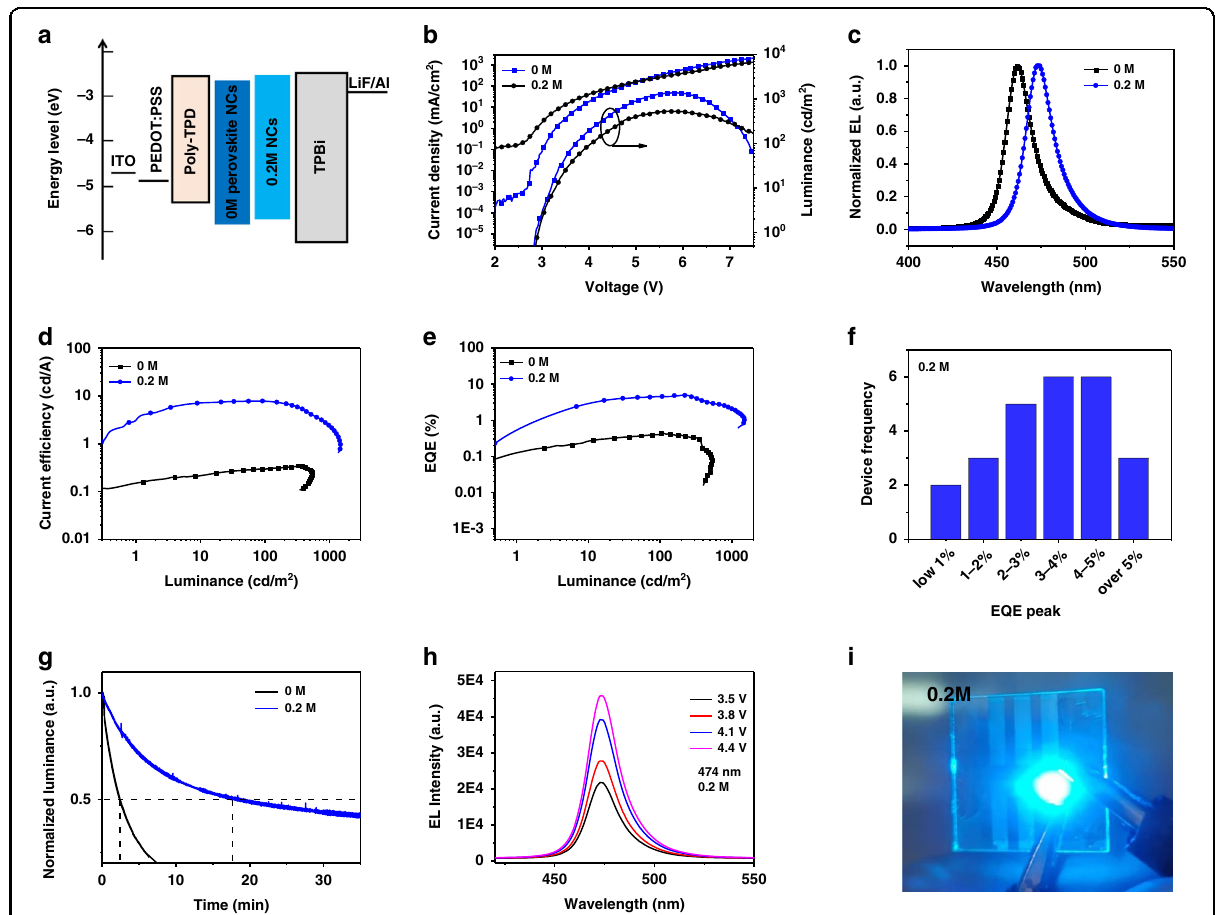
Fig. 6 Blue LED performances based on perovskite QDs. a Schematic band alignment of the LED devices with 0 and 0.2 M FA cation doped QDs. b Curves of the current density-voltage-luminance. c Normalized electroluminescence spectra of the LED devices with CsPb(Cl 0.5 Br 0.5 ) 3 (black curve) and 0.2 M doped CsPb(Cl 0.5 Br 0.5 ) 3 QDs (blue curve). d Curves of the brightness-current ef fi ciency. e Curves of the external quantum ef fi ciency- luminance. f The histogram of devices frequency-EQE maximum values in 0.2 M FA cation doped CsPb(Cl 0.5 Br 0.5 ) 3 QD LEDs. g Emitting stability of two devices. h Stable EL spectra of 0.2 M FA-doped sample at different voltages. i The photograph of a FA-doped device operating on the voltage of 5 V